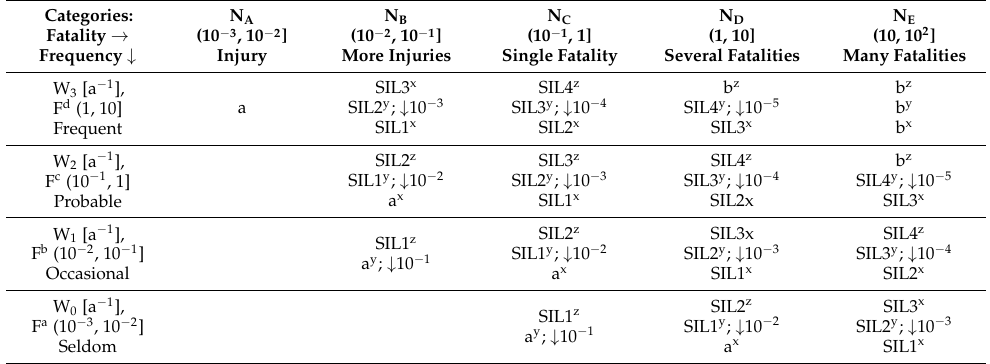
Table 2. Example of an extended risk matrix for determining safety integrity level.